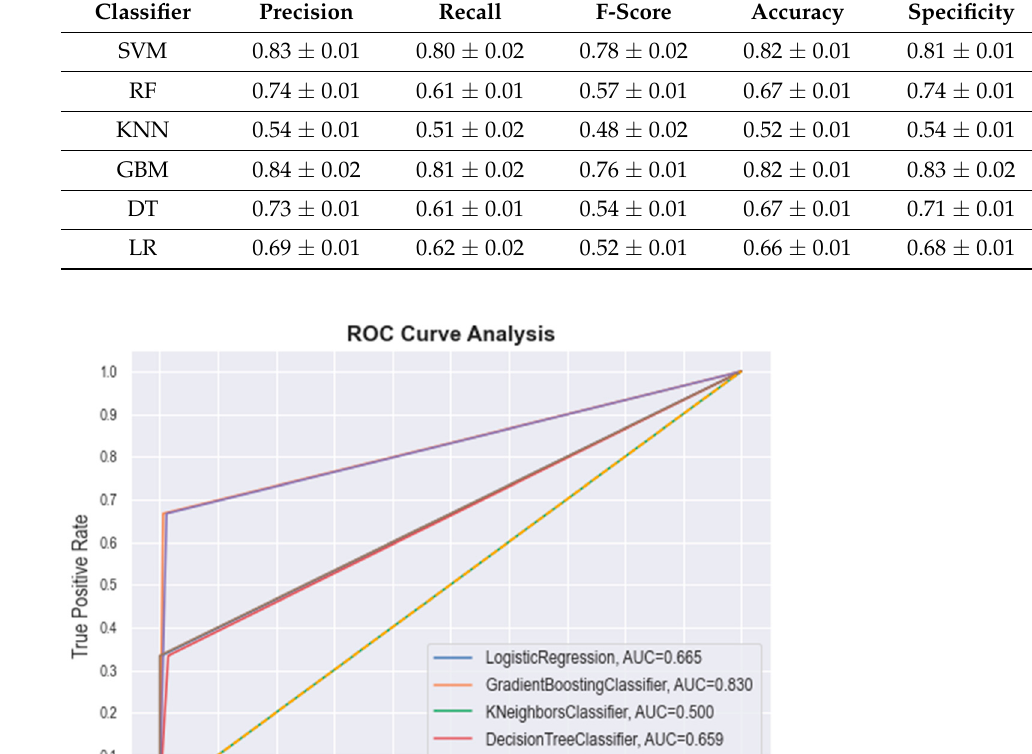
6 of 26 Table 1. Performance indices for 5-fold CV using different ML classifiers.